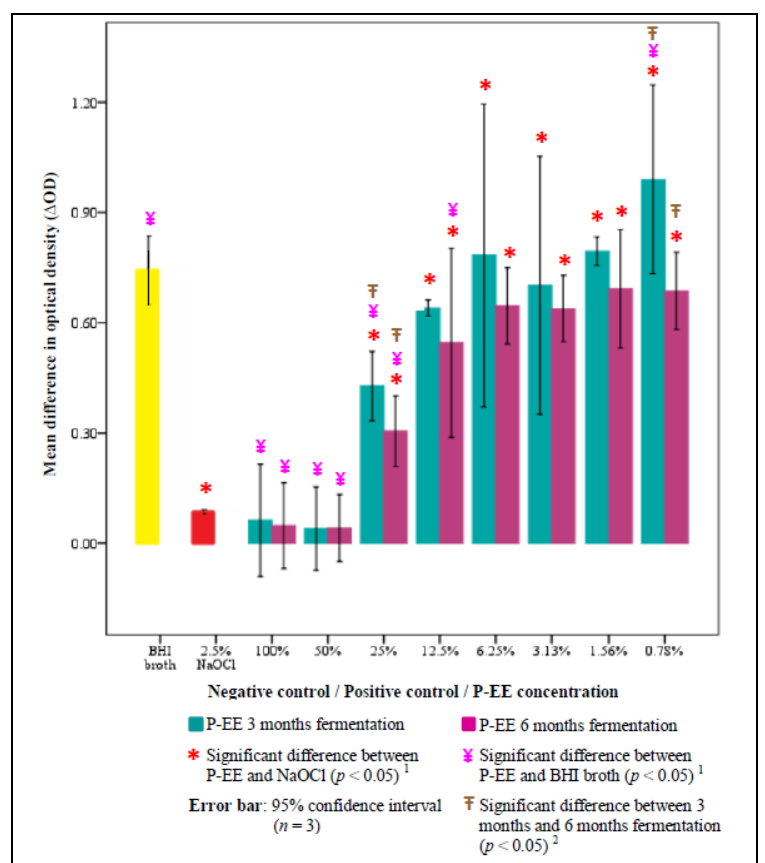
Figure 4. Mean difference in optical density between P-EE of different concentrations at 3 and 6 Figure 4. Mean di ff erence in optical density between P-EE of di ff erent concentrations at 3 and 6 months months fermentation, NaOCl, and BHI broth. 1 One-way ANOVA: Difference between P-EE, NaOCL, fermentation, NaOCl, and BHI broth. 1 One-way ANOVA: Di ff erence between P-EE, NaOCL, and BHI and BHI broth ( p < 0.05). 2 Independent-samples T-test: Difference between fermentation periods ( p < broth ( p < 0.05). 2 Independent-samples T-test: Di ff erence between fermentation periods ( p < 0.05). 0.05).